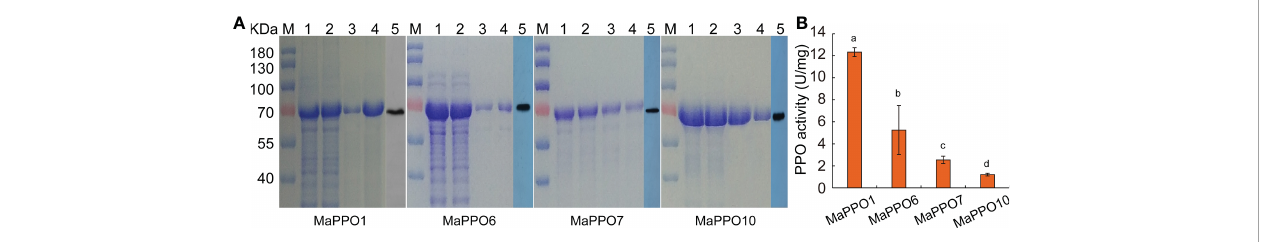
FIGURE 8 Prokaryotic expression, puri fi cation, and enzyme activity analysis of selected MaPPO proteins. (A) SDS-PAGE of MaPPO1, MaPPO6, MaPPO7, and MaPPO10 at different puri fi cation stages. M, Molecular weight marker; 1, Bacterial lysate, 2, Total soluble protein fraction; 3, 4, Puri fi ed His-fusion; 5, Immunodetection of His-PPO using an anti-His antibody. (B) Polyphenol oxidase activity of puri fi ed recombinant MaPPO proteins. Different letters indicate signi fi cant differences (P < 0.05) examined by one-way